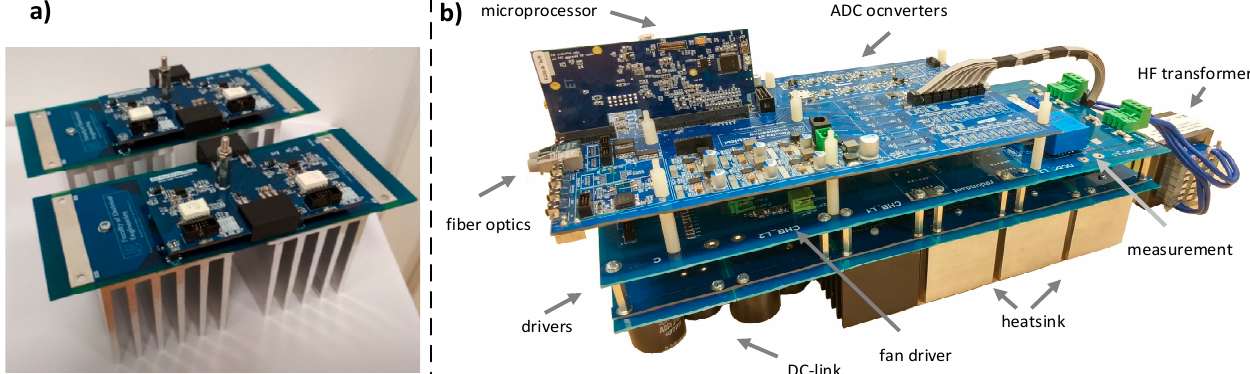
Figure 12. Experimental setup: ( a ) view of designed power and driver boards of a single SM of a CHB converter, ( b ) view of designed single SM of a AC-MV to DC-MV converter with H-bridge of an IPOP DAB.